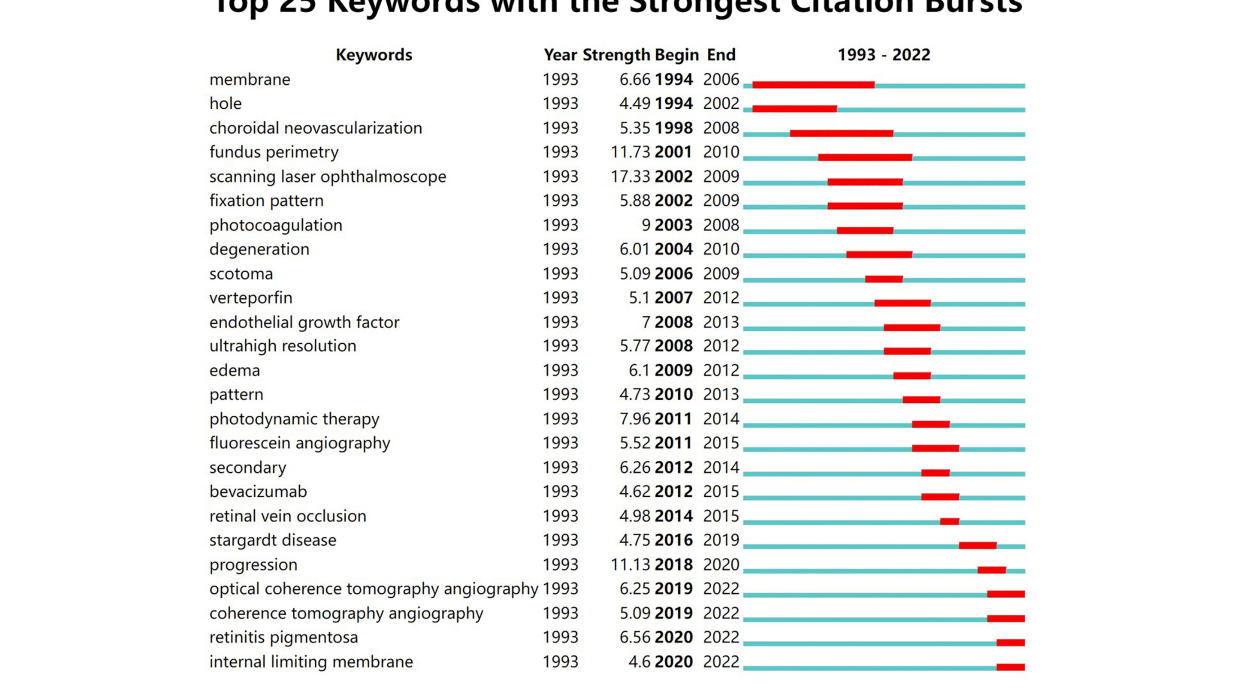
FIGURE11 Top 25 keywords with the strongest citation bursts in microperimetry. The red bar in the green timeline demonstrated the burst period of specific